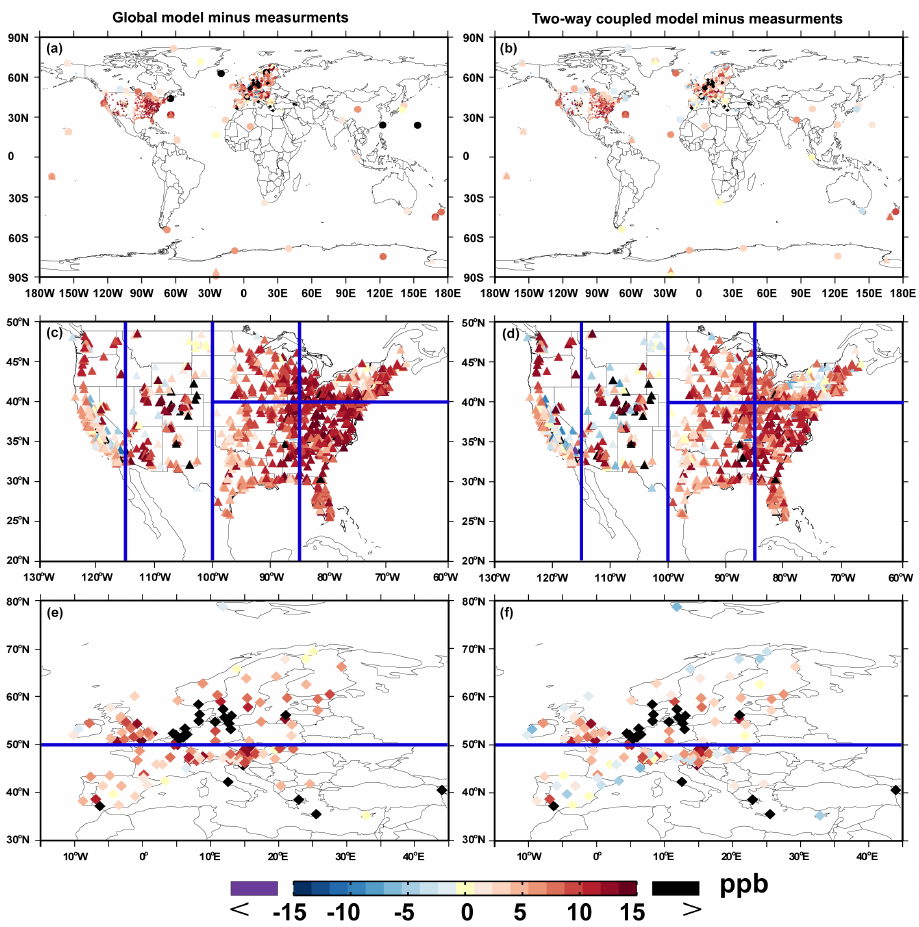
Figure 3. Anneal mean model biases in afternoon (12:00–18:00LT) mean ground-level ozone for the global model alone (a) and the two- way coupled model (b) , with respect to measurements from WDCGG, GMD, AQS and EMEP. The symbol shapes differentiate measurement networks, consistent with Fig. 1 (circle for WDCGG, large triangle for GMD, small triangle for AQS, and diamond for EMEP). The US and European domains are enlarged in panels (c–f) to better show spatial distributions. Blue lines separate the regions presented in Fig.